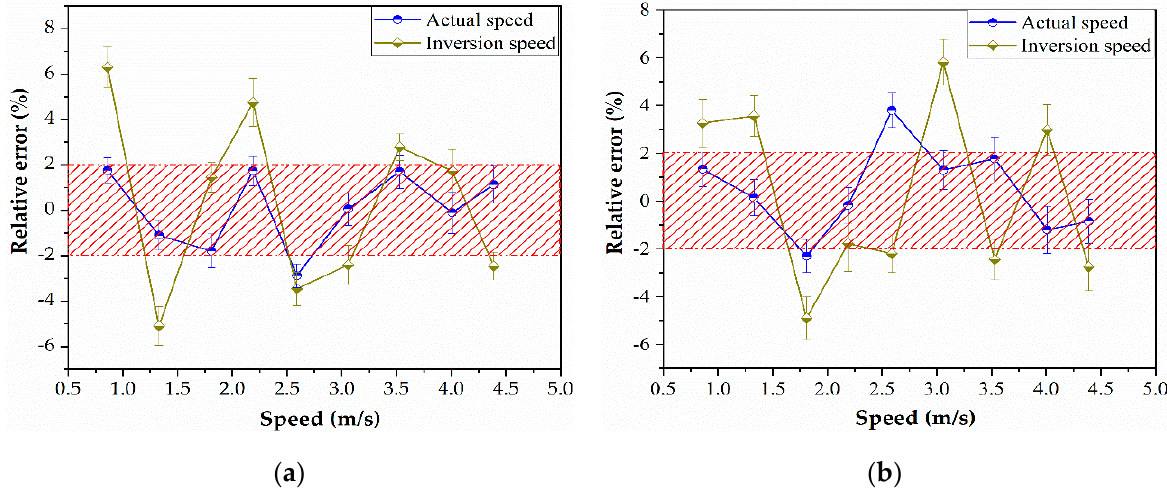
Figure 16. Influence of vehicle speed on load identification: ( a ) Two-axle vehicle, ( b ) three-axle vehicle.